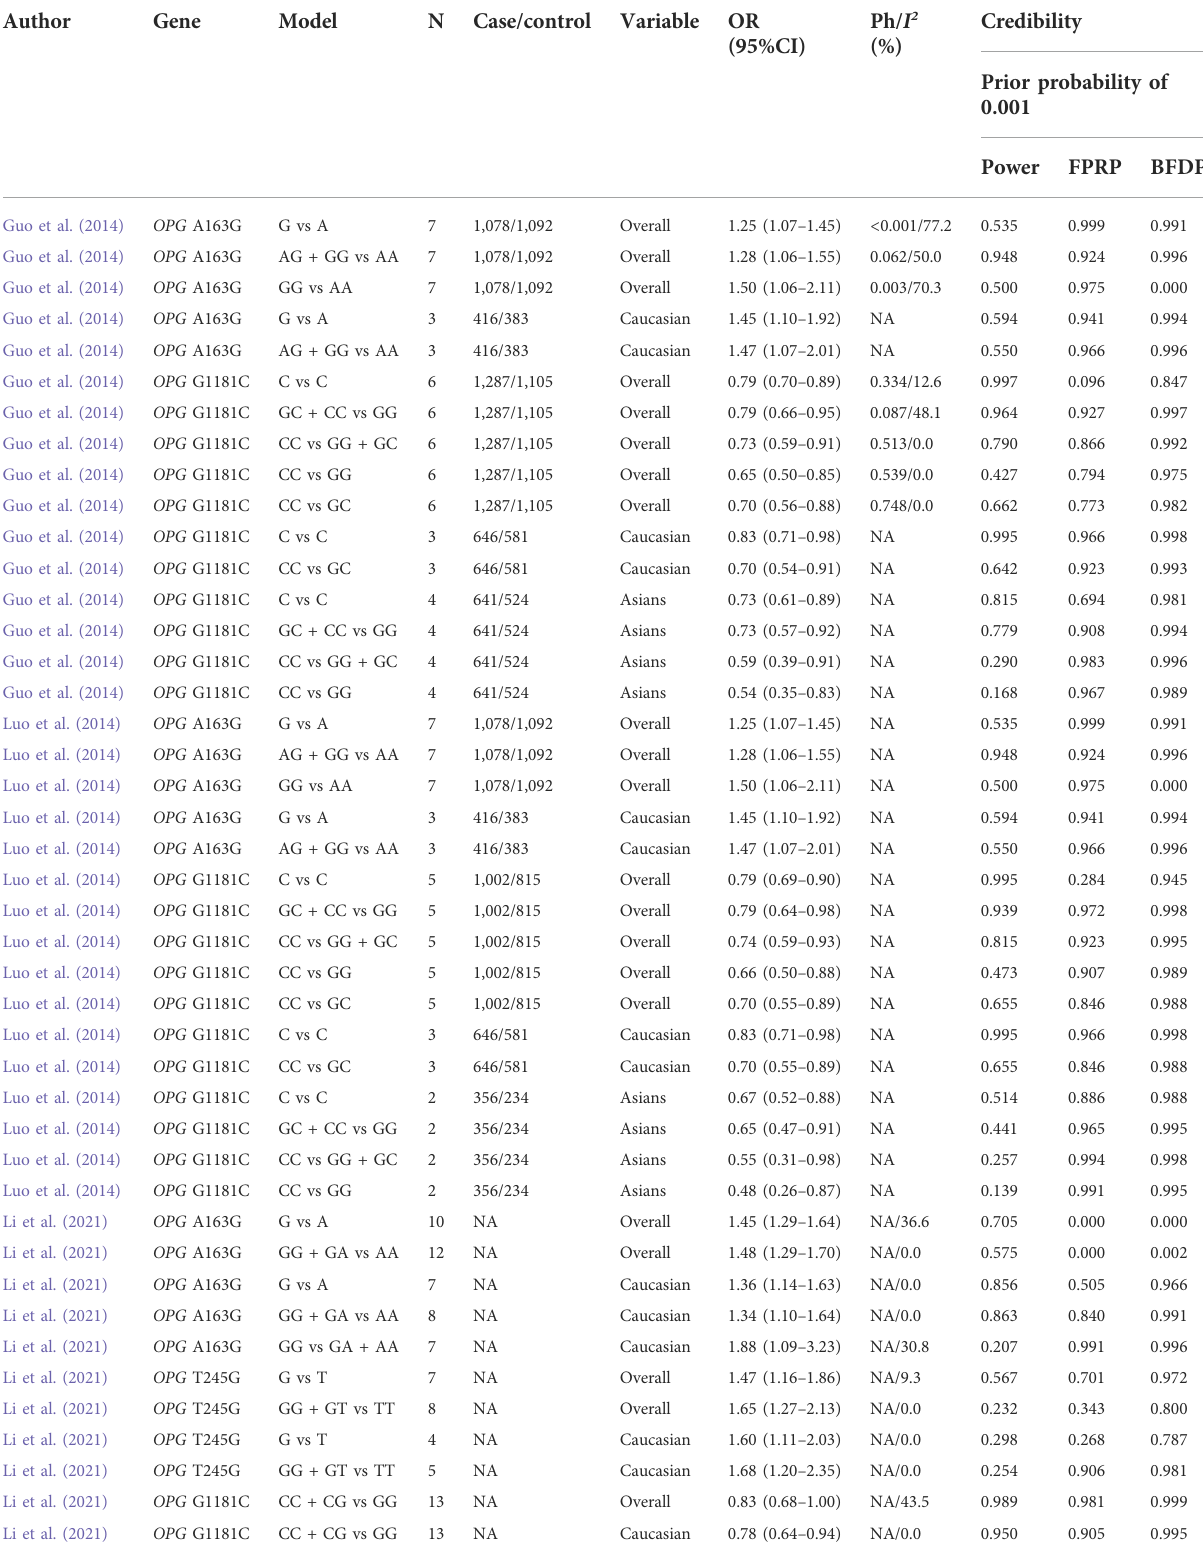
TABLE 5 Credibility of previously published